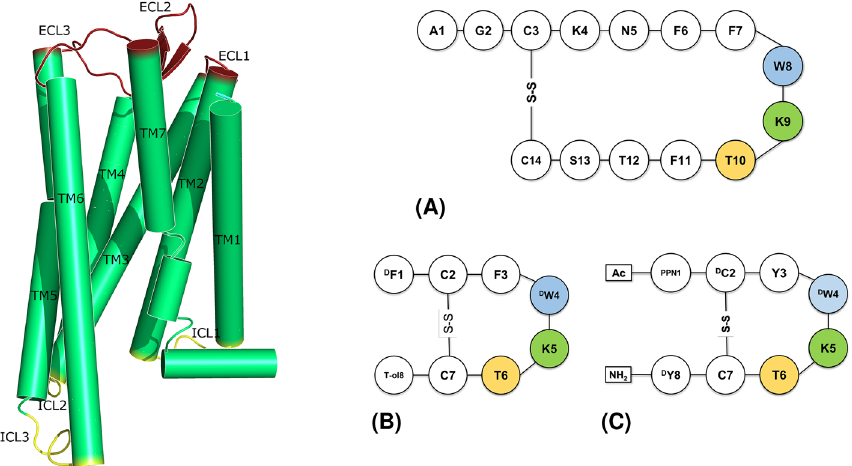
Figure 1. Left panel: Schematic representation of GPCR structure and main domains. Transmembrane helices 1.33 2.38 2.65 3.22 3.55 4.33 4.64 1.59 (green): TM1 = A44 -R70 , TM2 = I77 -A104 , TM3 = K112 -V145 , TM4 = I150 -A181 , 5.32 5.67 6.24 7.56 6.59 7.29 TM5 = G202 -S237 , TM6 = R245 -V280 , TM7 = P288 -L315 . Extracellular loops (red): ECL1 = L105-G111, ECL2 = G182-S201, ECL3 = S281-T287. Intracellular loops (yellow): ICL1 = Y71-T76, ICL2 = H146-P149, ICL3 = V238-S244. Right panel: 2D sketches of SSTR2 agonists: (A) SST14 and (B) octreotide (T-ol = threoninol), and ( C ) the antagonist CYN154806 (Ac = acetyl group, PPN = Phe-NO 2 ). Conserved residues are